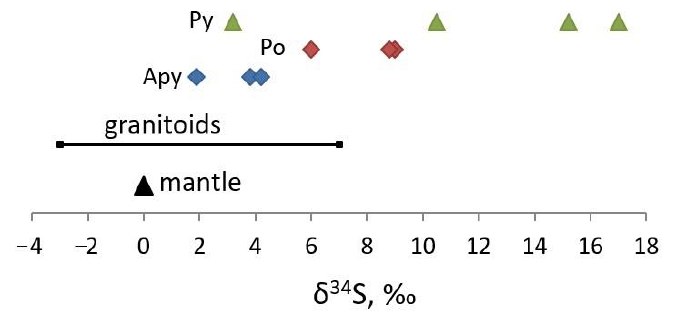
Figure 12. Variations in the sulfur isotopic composition of sulfides from the Dobroe deposit: Apy—arsenopyrite, Po—pyrrhotite, Py—pyrite. The sulfur isotopic composition of sulfides from granitoids is given according to [51].